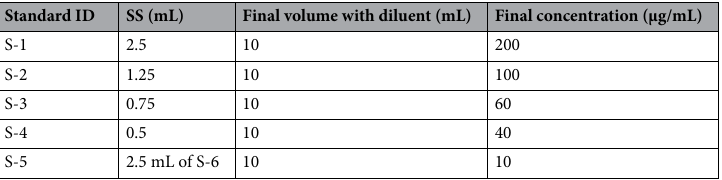
Table 2. Preparation of the working standard solutions.